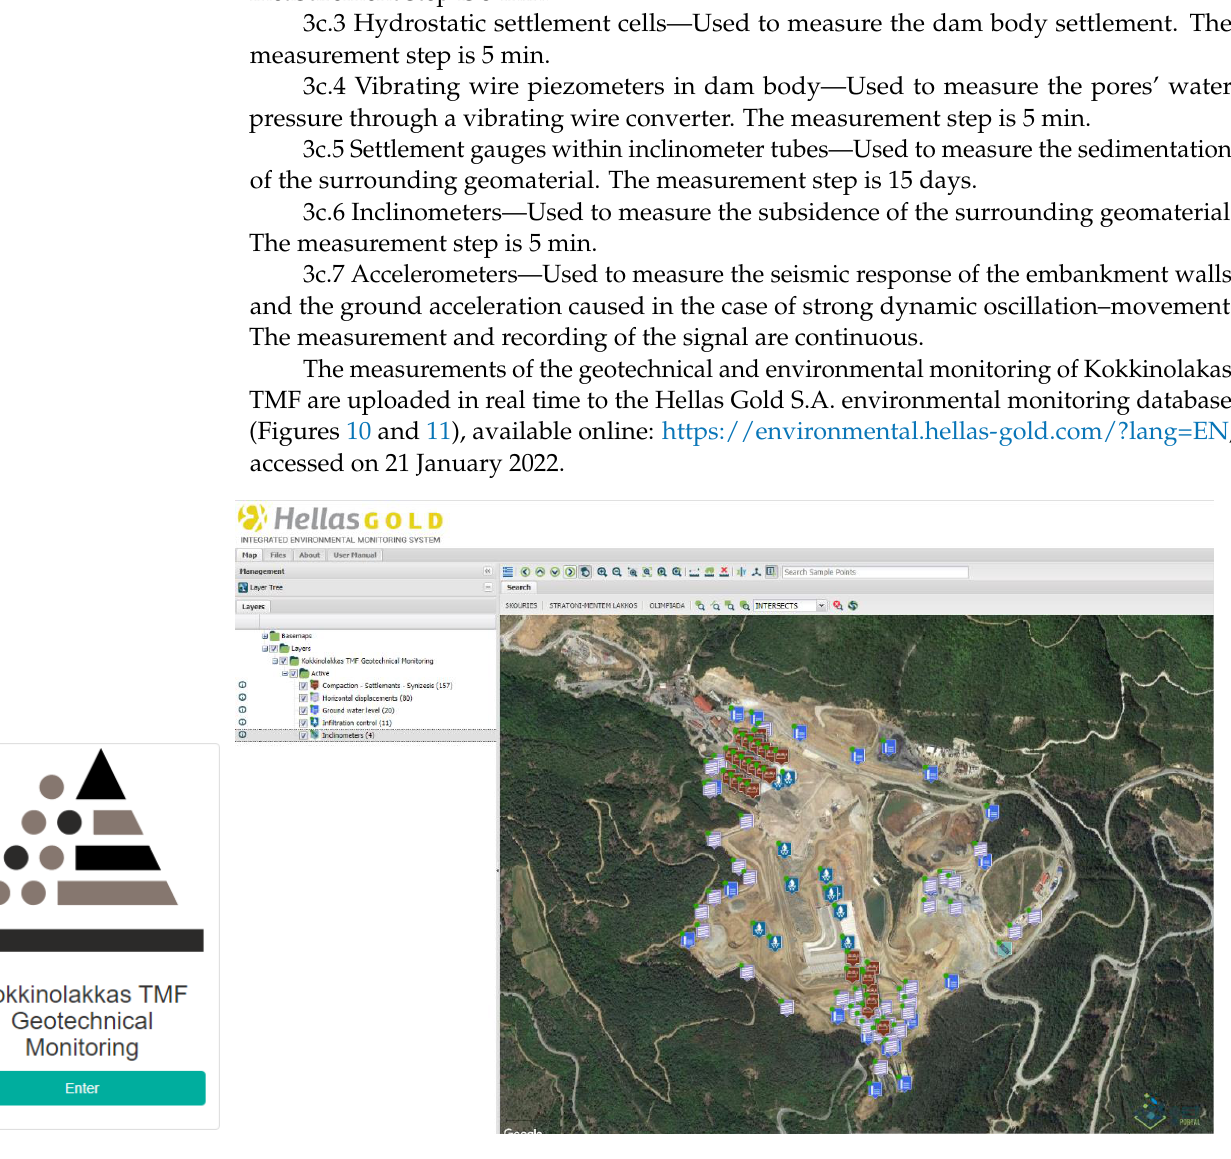
Figure 10. Monitoring database main screen.